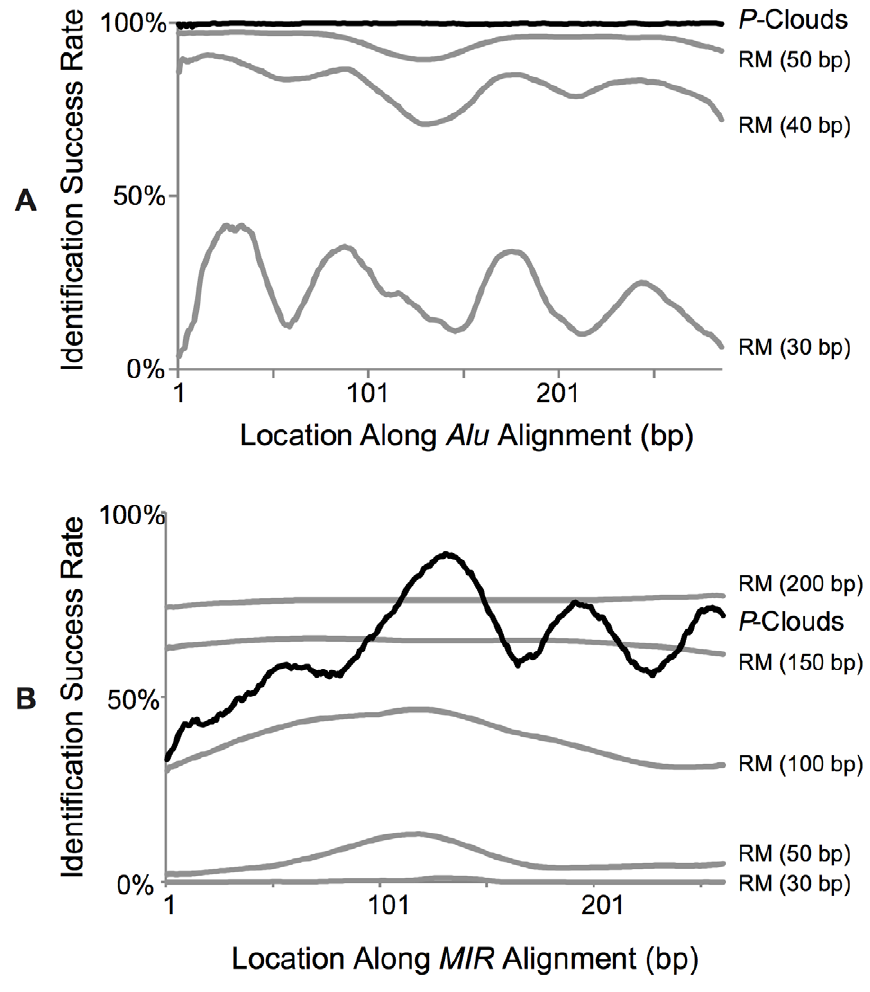
Figure 5. Percent detection success for fragments of known full-length SINE elements. A) Alu regions. B) MIR regions. Identification success is displayed as a running average of 10 bp starting